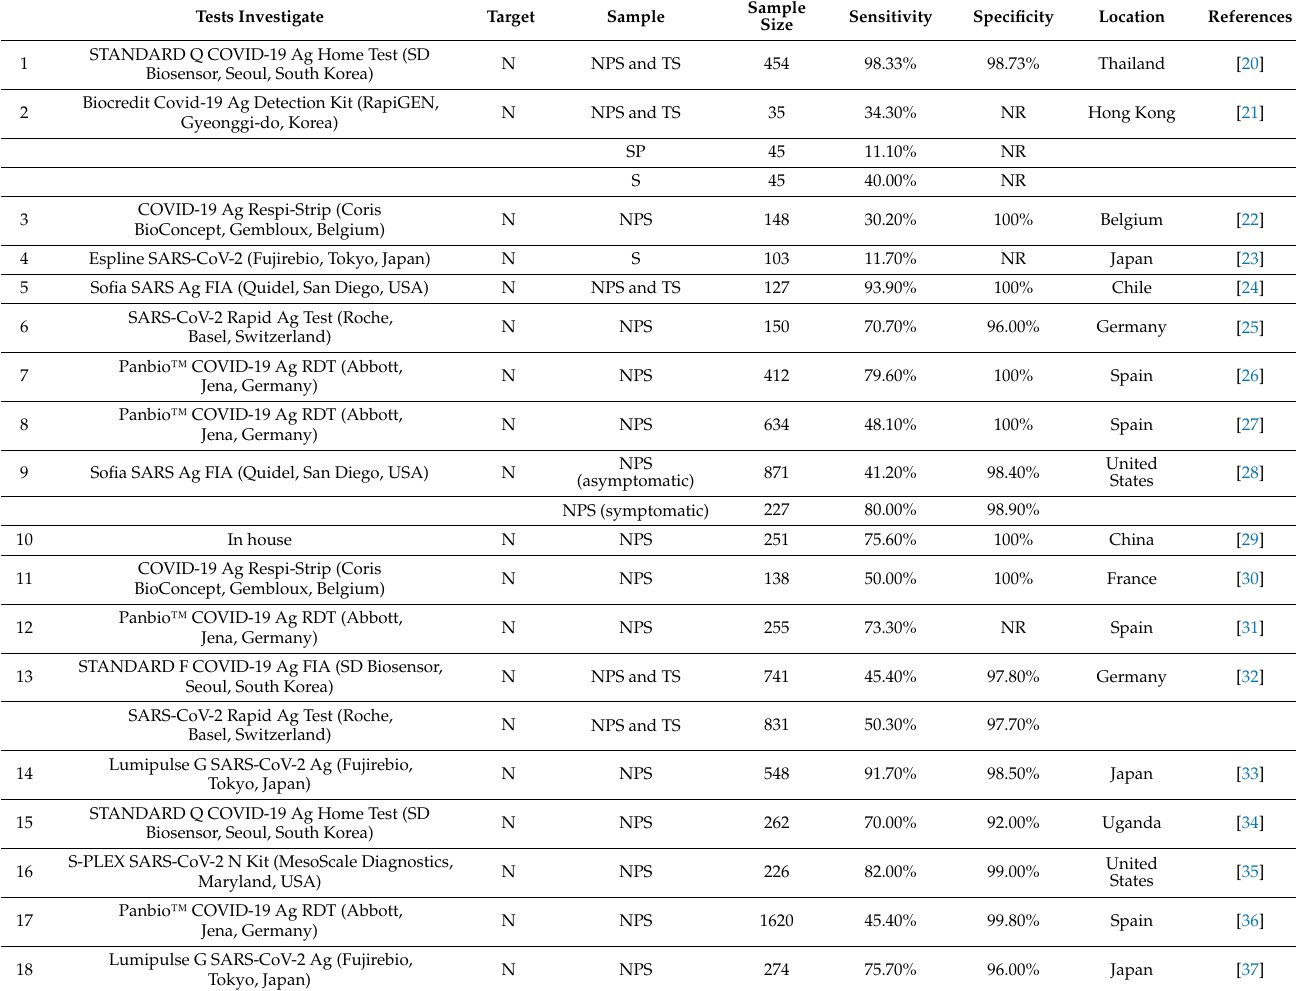
Table 2. Characteristics of included